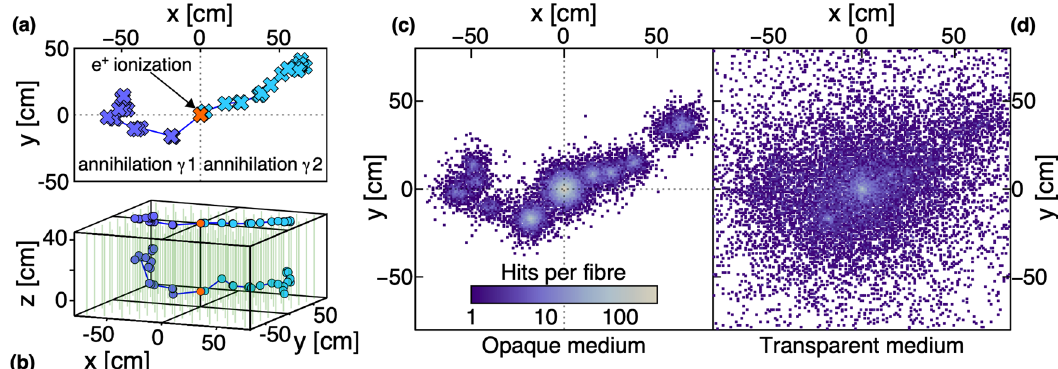
Fig. 1 Detection principle and imaging capability. The energy depositions in a LiquidO detector from a simulated e + with 1 MeV of kinetic energy plus the associated annihilation gammas are used to illustrate the detection principle and imaging capability. a shows a two-dimensional x - y projection of the energy depositions in the scintillator, while b shows the full three-dimensional extent. The green lines running in parallel with the z -axis represent the fi bres in the simplest con fi guration of the detector geometry. The energy deposition of the e + is shown by the orange point and the Compton scatters of the 0.51 MeV back-to-back annihilation γ ’ s by light and dark blues. One of the γ ’ s (dark blue) turns upwards to run approximately parallel with the fi bres and this is re fl ected by its shorter extent in the x - y projection. The simulation of the light hitting each fi bre in a 1-cm-pitch lattice is shown in two scenarios: on c an opaque scintillator with a 5 mm scattering length is simulated, whereas on d the scintillator is transparent. The colour of each point represents the number of photons hitting a fi bre at that x - y location. With a transparent medium the resulting image from the fi bre array is almost completely washed out. In stark contrast, the light con fi nement around each energy deposition with the opaque scintillator allows preservation of the event ’ s precious topological information and the formation of a high-resolution